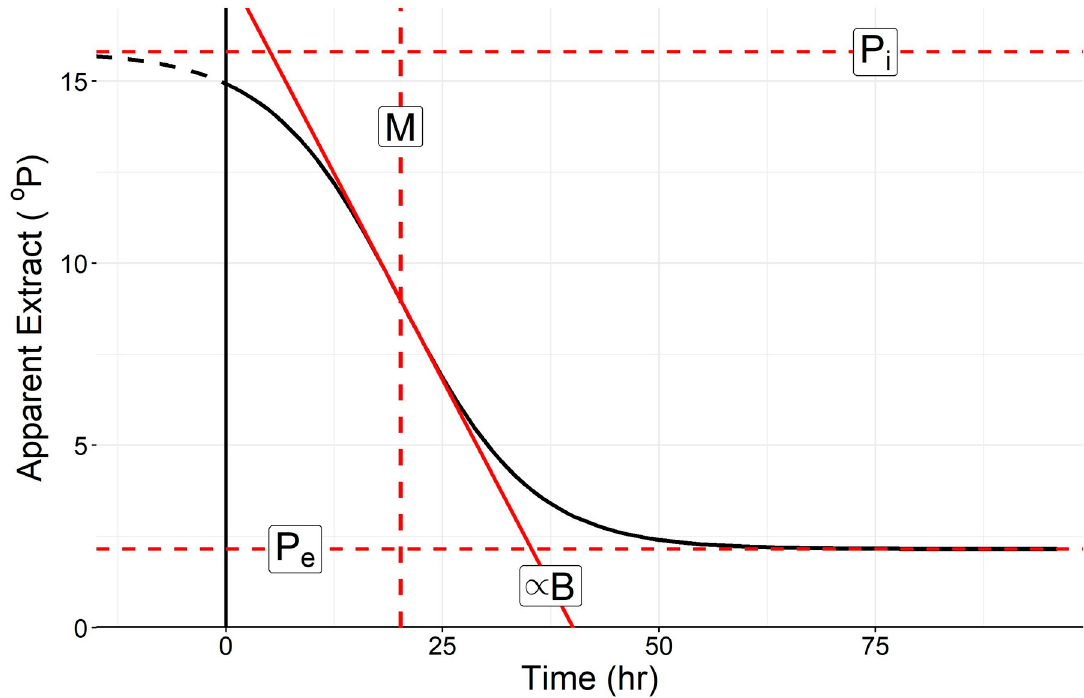
Figure 1. The shape of a four-parameter logistic equation modeling the decline in density with time for a typical fermentation (modified from Speers et al. [1,3]).